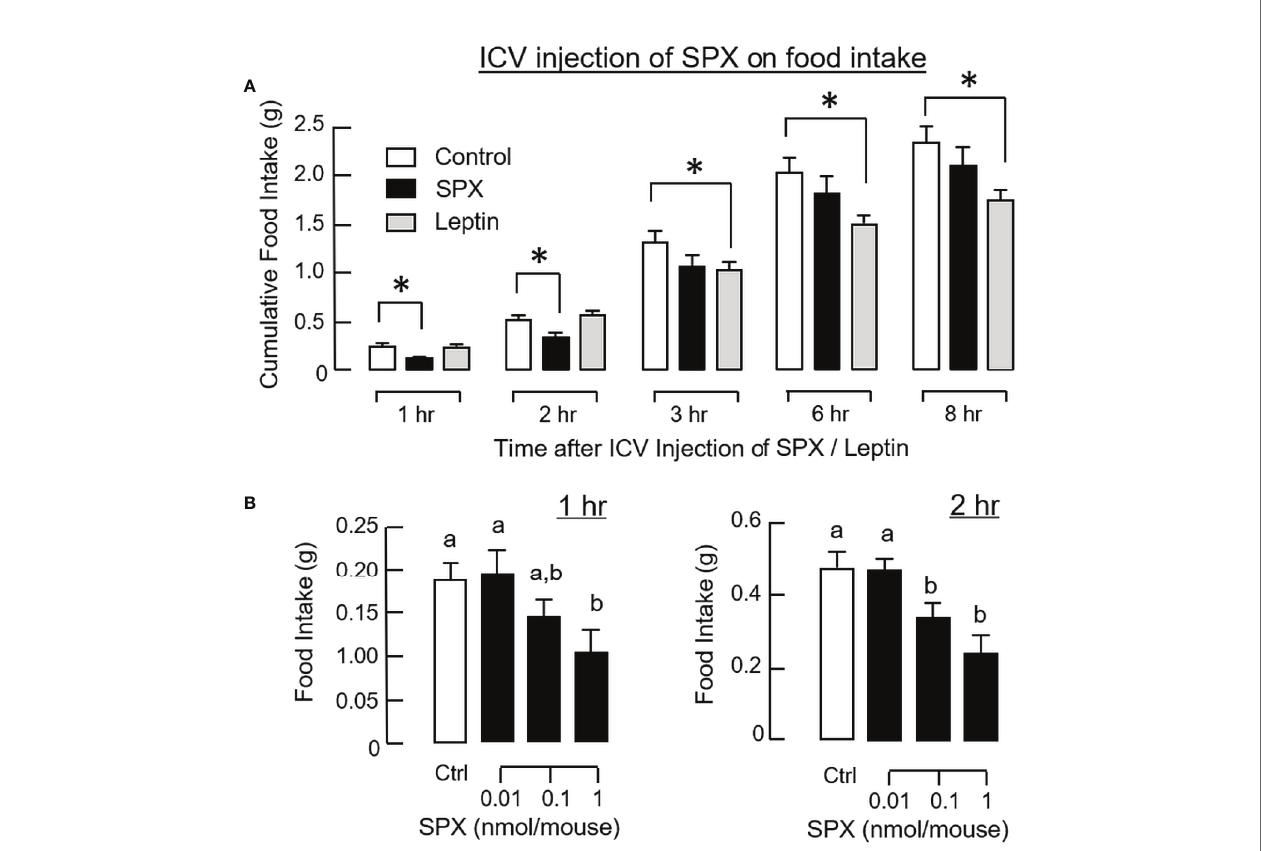
FIGURE 6 | Central administration of SPX on food intake in mice. Time course (A) and dose dependence (B) for SPX treatment by ICV injection on food consumption. For time course study, SPX was tested at a dose of 1 nmol/mouse to examine its effects on food intake up to 8 h. For dose dependence, the corresponding effects of increasing levels of SPX (0.01-1 nmol/mouse) were monitored for 1 and 2 h, respectively. In these studies, ICV injection with arti fi cial CSF was used as the control treatment and parallel injection with leptin (1 nmol/mouse) was conducted as a positive control for feeding response. The groups denoted by asterisks (*)/different letters represent a signi fi cant difference at p <